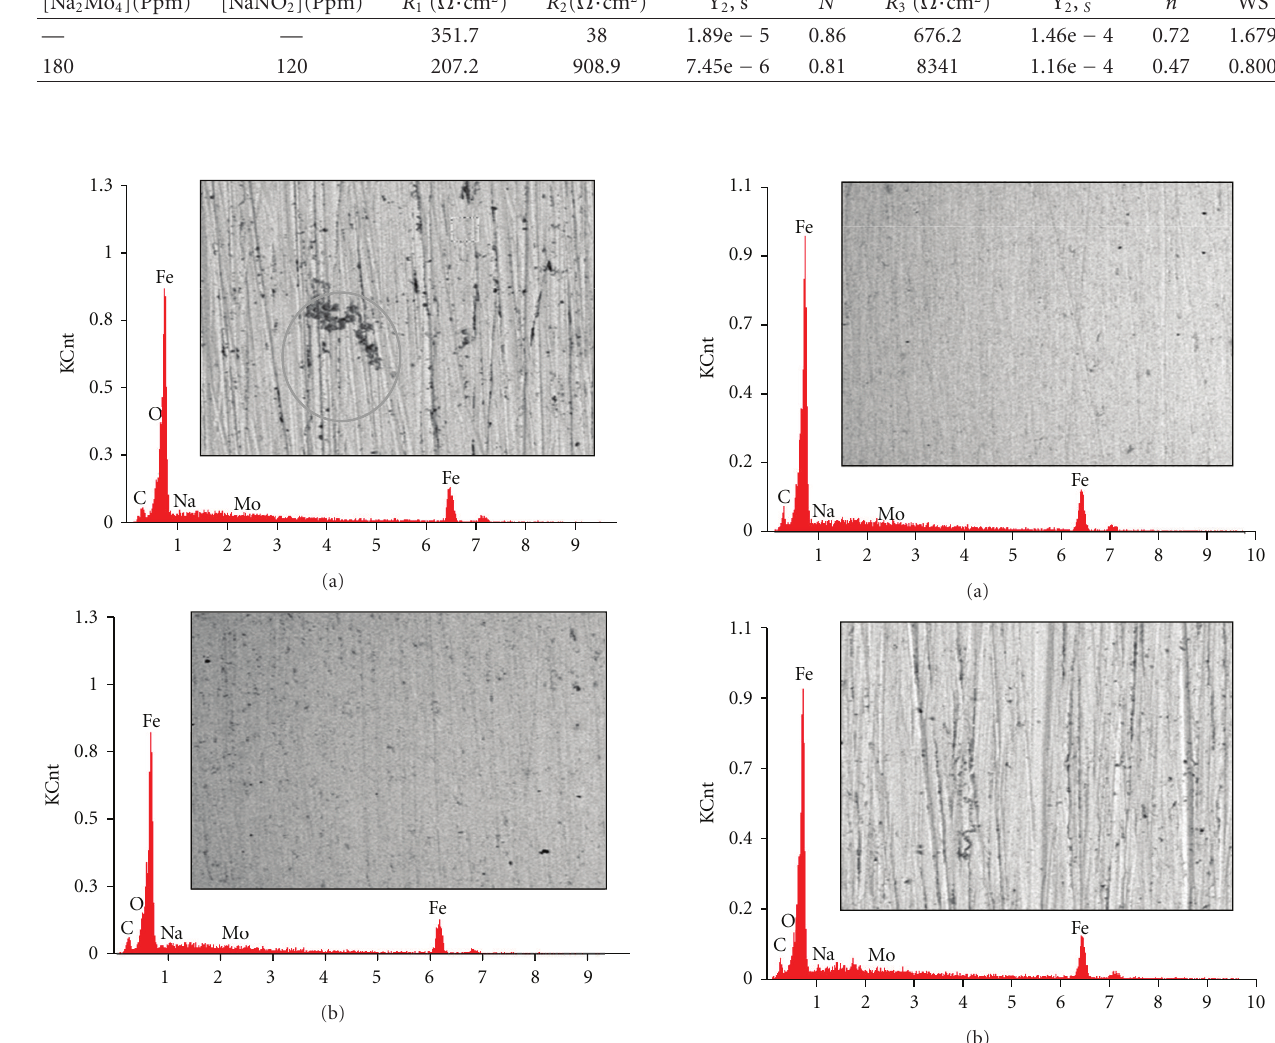
with molybdenum can repair the defect of the iron passive in borate bu ff er solution and inhibit pit growth